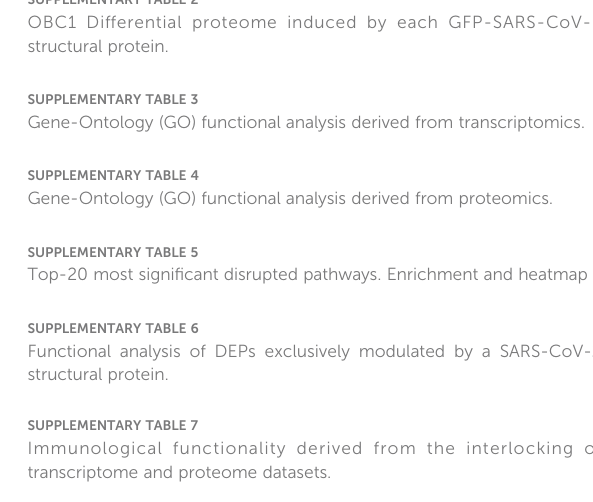
SUPPLEMENTARY FIGURE 2 (A) Commonalities and differences across differential expressed transcripts induced by SARS-CoV-2 proteome expression. (B) Functional analysis of transcriptomics datasets.